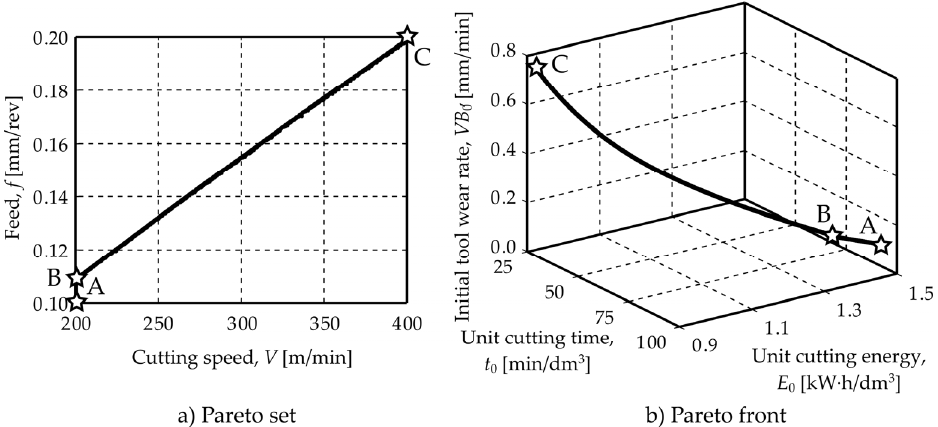
Figure 9. Values obtained in the optimization for dry machining. ( a ) graph of the Pareto set, ( b ) graph of the Pareto front (A, B and C: most relevant solutions for the selection of machining pa- rameters).